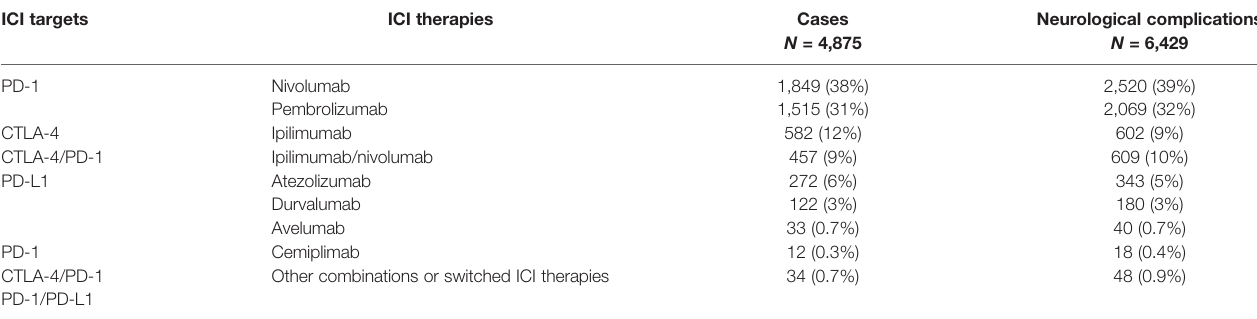
TABLE 1 | Cases describing neurological events occurring in patients receiving at least one ICI collected in EudraVigilance and categorized by pharmacological